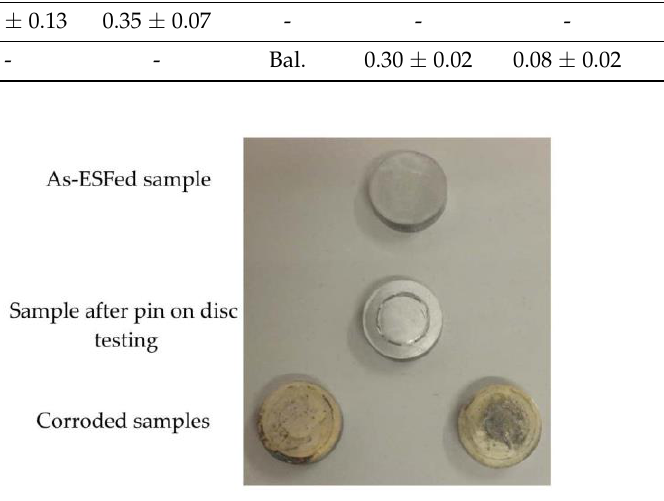
Table 1. Chemical composition of the powder used for the fabrication of specimens in weight percentage. Powder